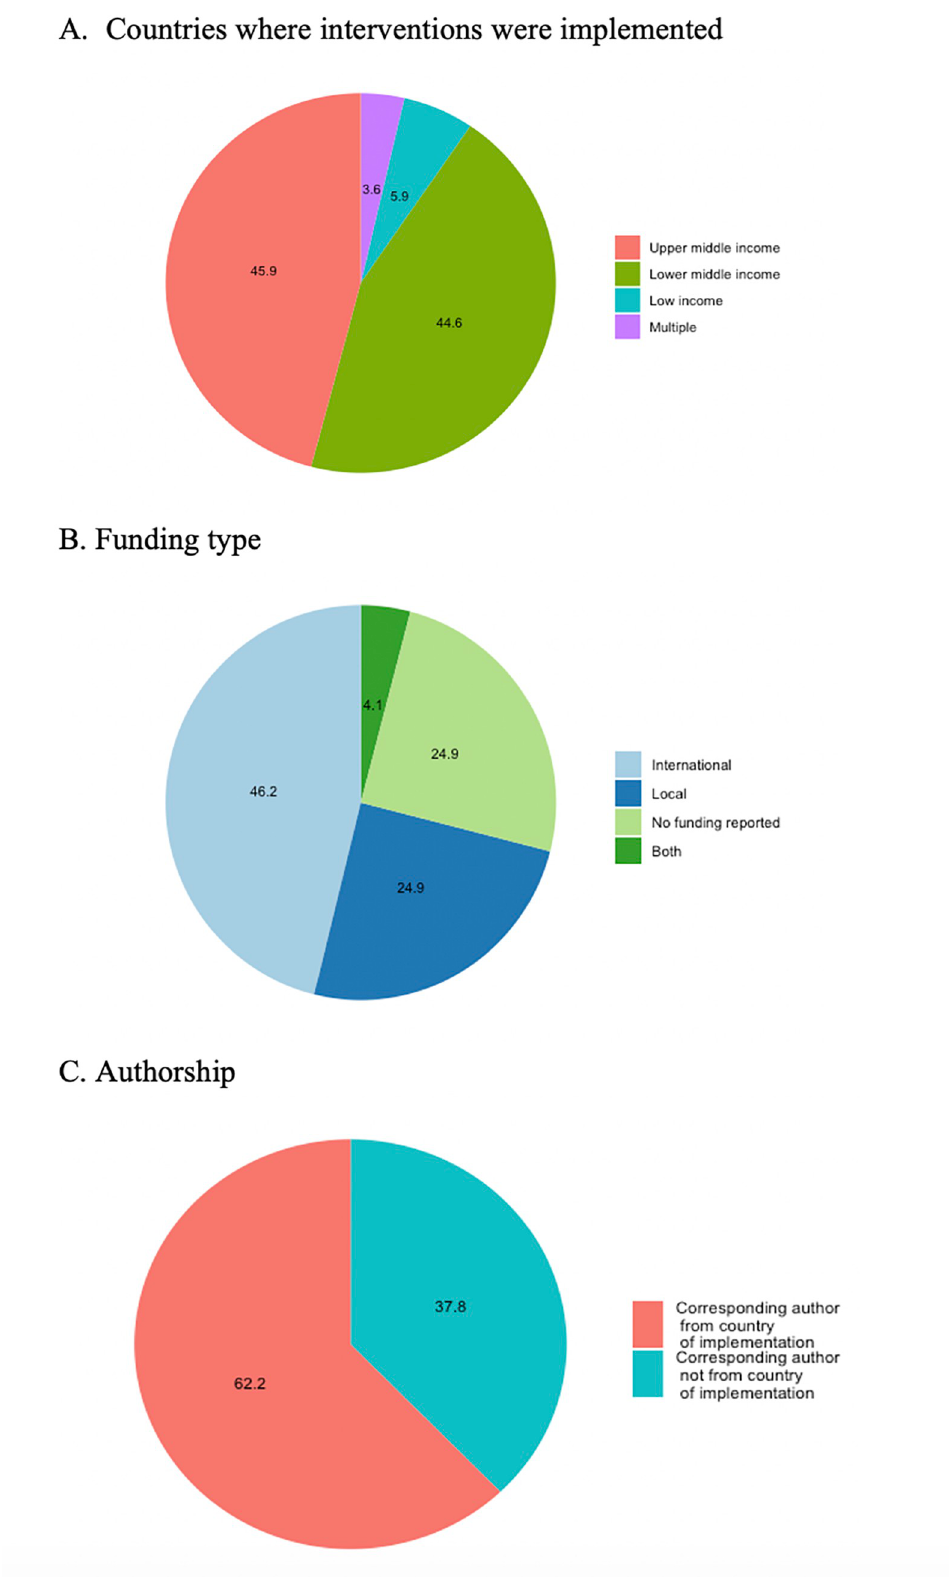
Fig 4. Distribution of study countries, funding, and authorship ( N =